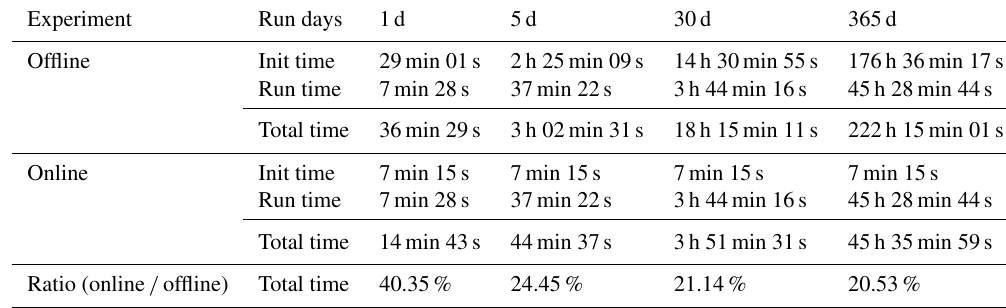
Table 6. Comparison of CPU time in offline cda experiments and online cda experiments.